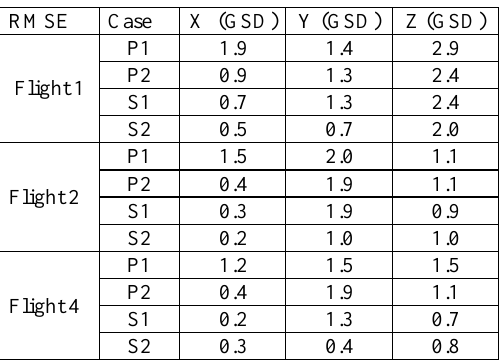
Table 4. Discrepancies at CP in GSD units for the different flights and calibration